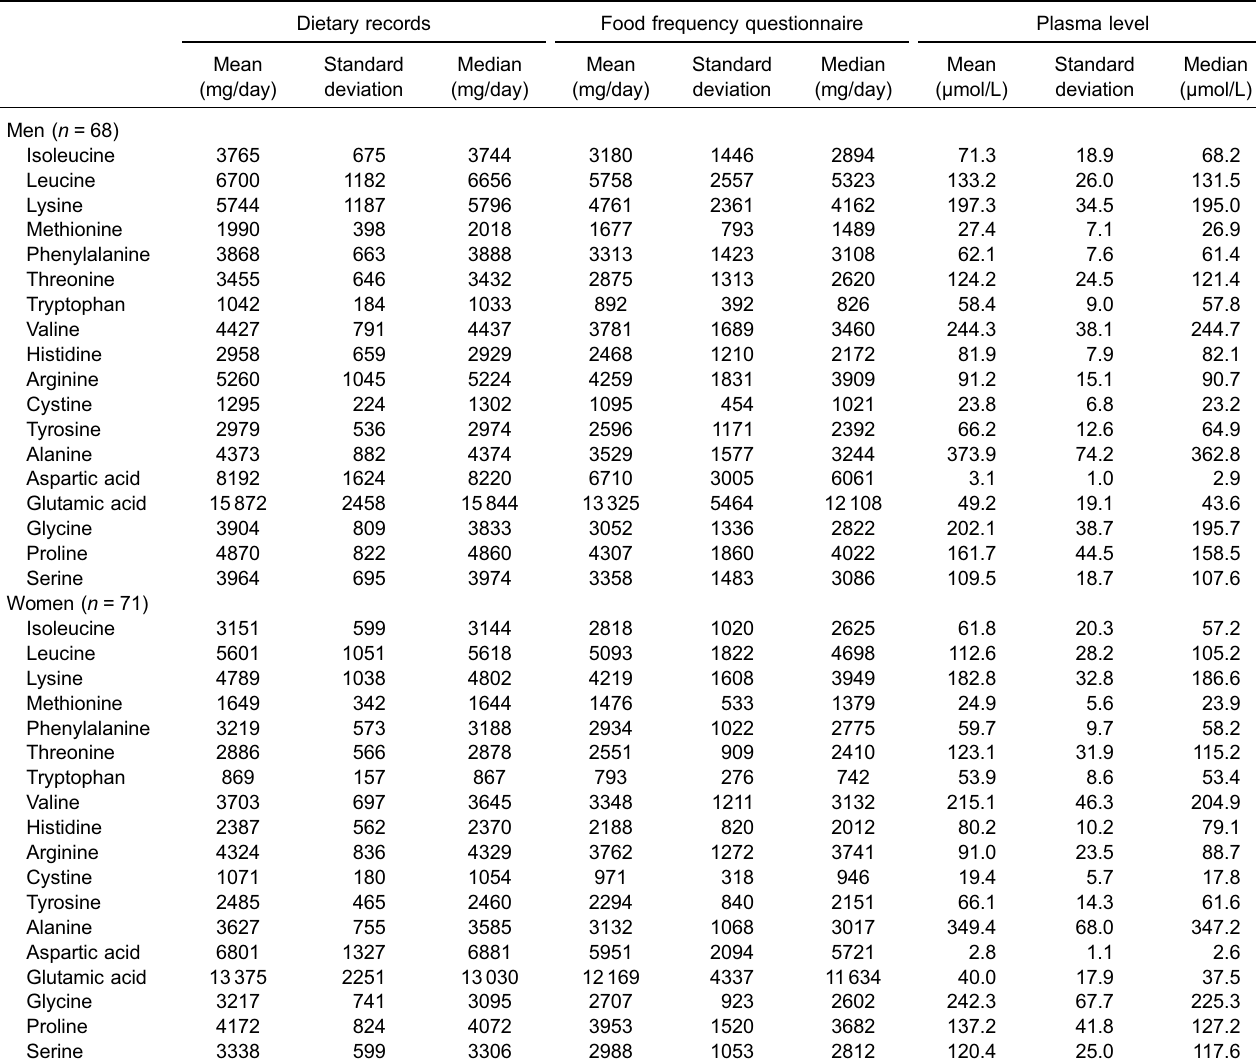
Table 2. Amino acid intake assessed with dietary records and food frequency questionnaire, and plasma amino acid level Dietary records Food frequency questionnaire Plasma level